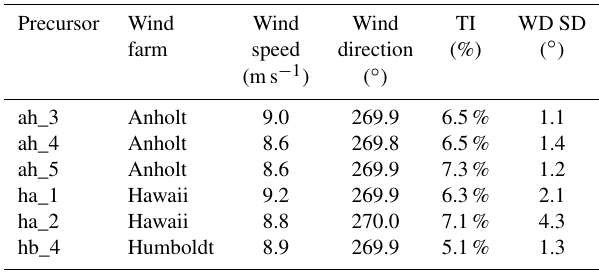
Table 1. Summary of the SOWFA precursor simulations used in the full wind farm